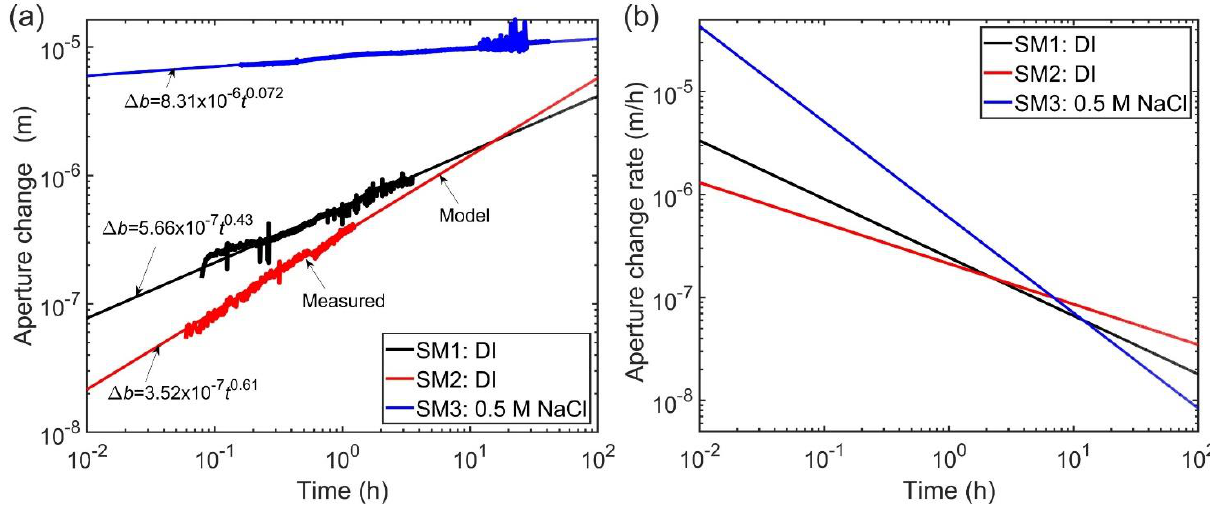
Figure 12. Measured and calculated (with Equation (7)) aperture change with time in log-log plot ( a ), where all parameters are derived based on the fitting curves in Figure 11, and ( b ) fracture aperture change rate as a function of time.